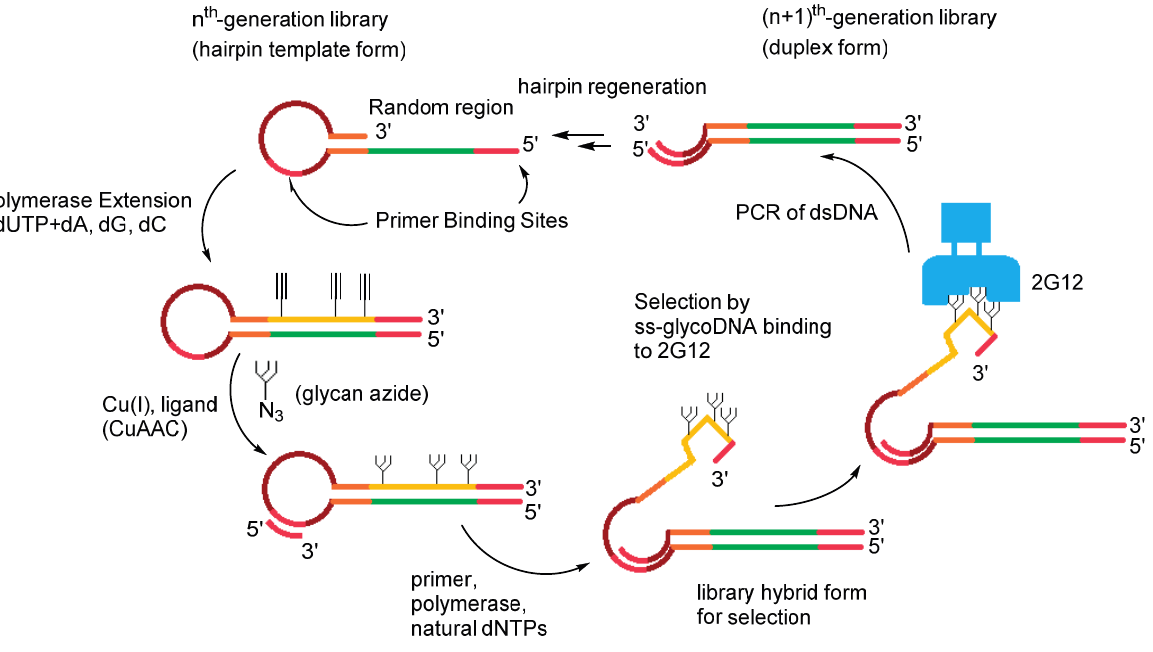
Figure 5. Schematic overview of the SELMA method. Figure adapted from reference